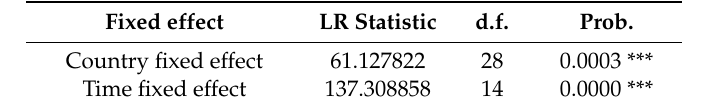
Table 10. Combined significance test results of province and time fixed effects for conditional